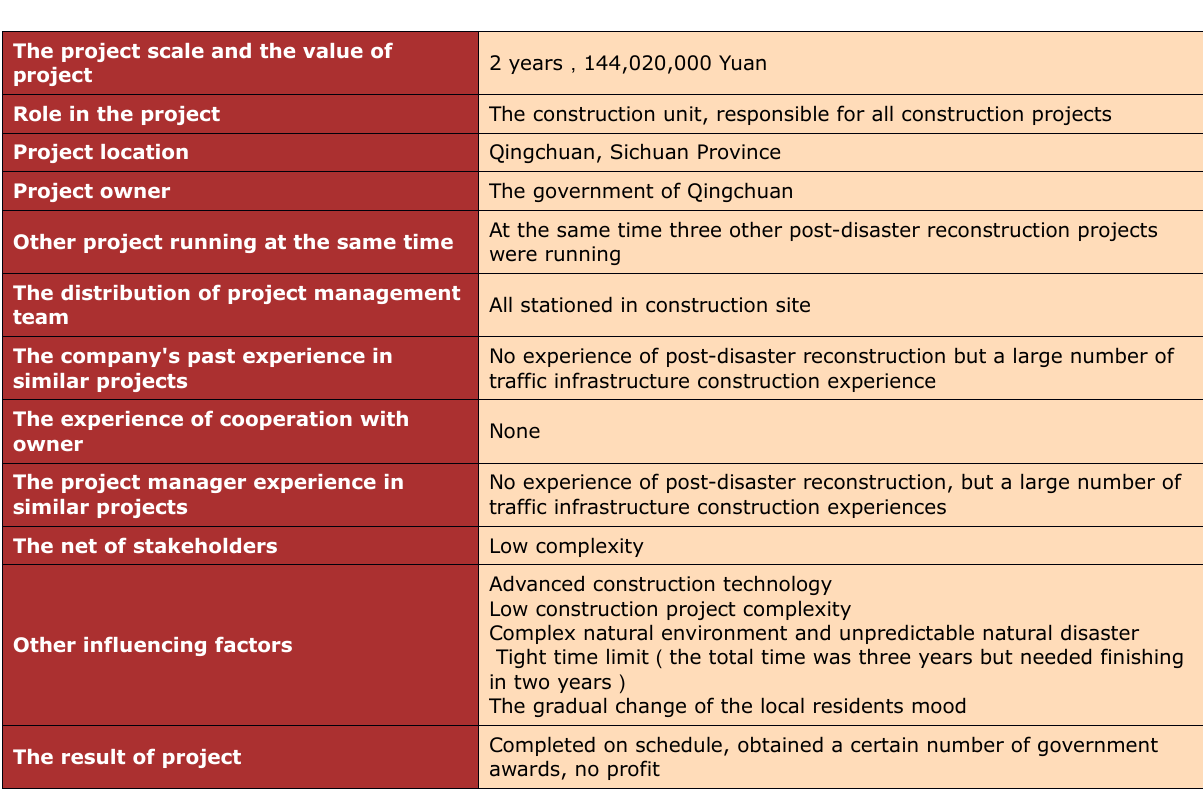
Table 3. Summary of the case